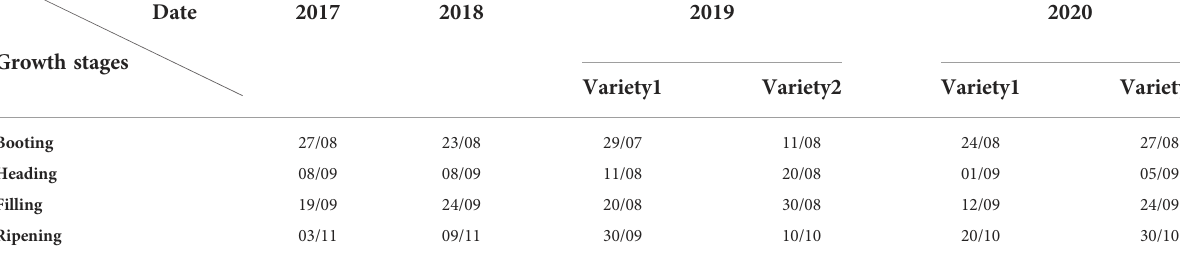
TABLE 1 Dates for unmanned aerial vehicle (UAV)-based hyperspectral image